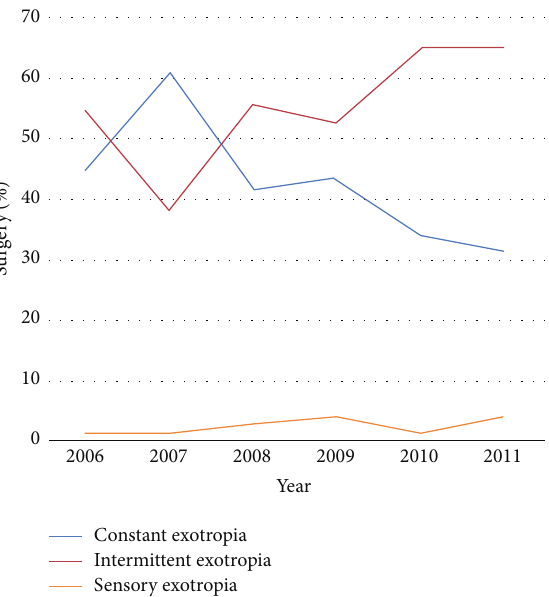
Figure 3: Distribution of concomitant exotropia surgery.